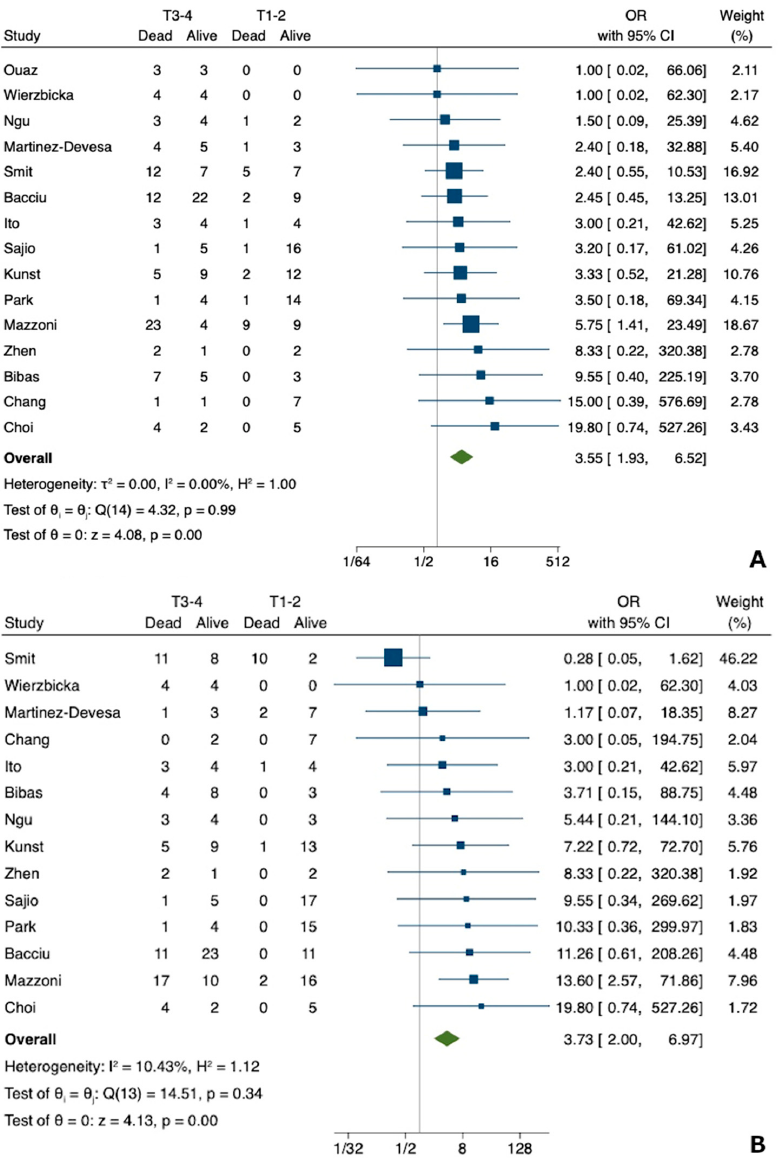
Figure 3. Forest plot for the odds ratio of cT category and survival (( A ) overall survival [4,22–35]; and ( B ) disease specific survival [4,22–28,30–35]) in temporal bone squamous cell carcinoma of the external auditory canal.